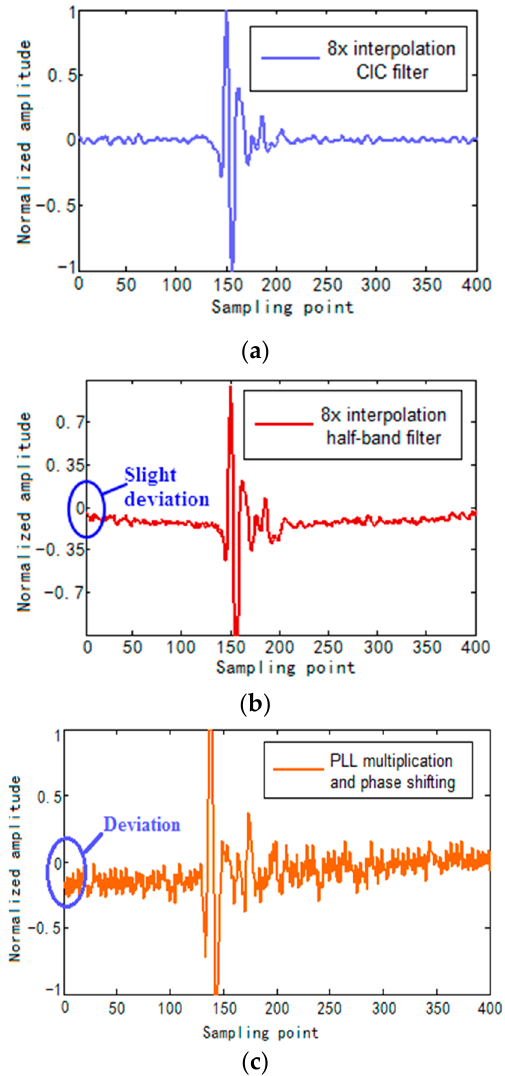
Figure 13. Synthesized A-scan defect echo signal. ( a ) 8 × interpolation CIC filter; ( b ) 8 × interpolation half-band filter; ( c ) PLL multiplication and phase shifting.